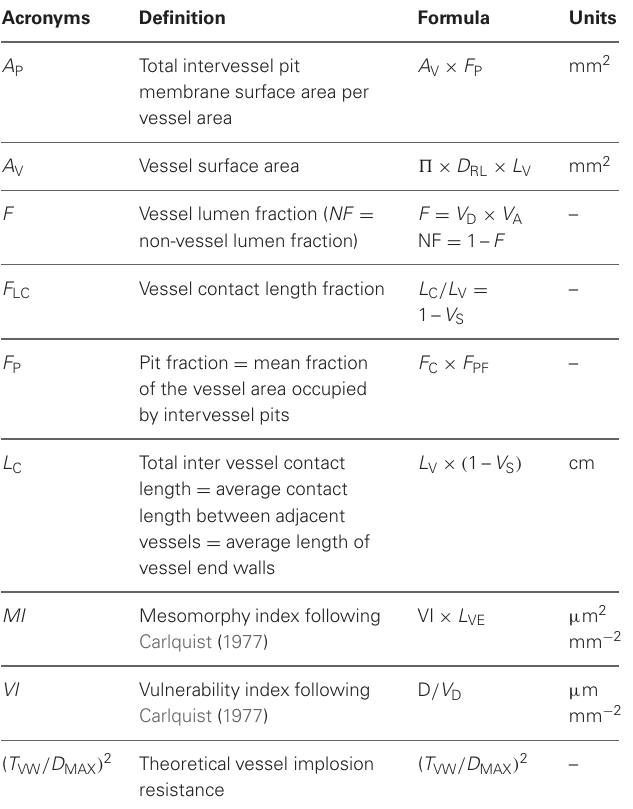
Table 2 | Overview of derived quantitative conduit characters with reference to their acronym, definition, formula, and units.